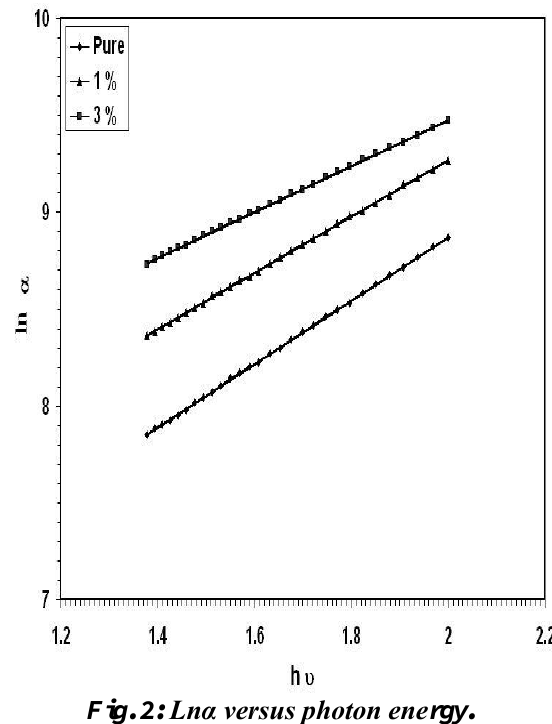
Fig. 2: Lnα versus photon